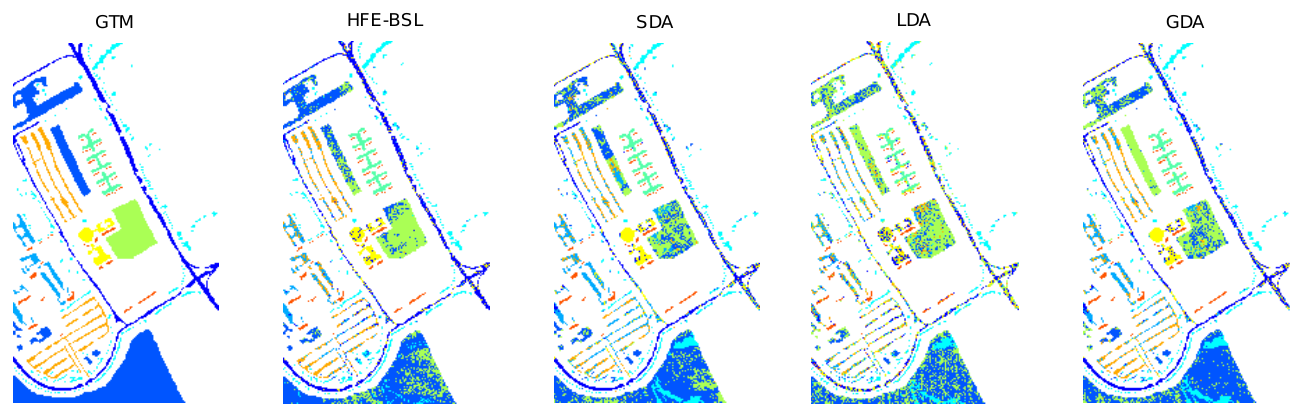
Figure 5. GTM and classification maps for Pavia dataset (16 training samples and 8 extracted features are